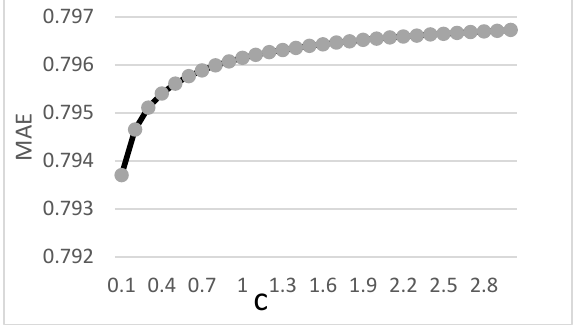
Figure 4. Relationship between c and